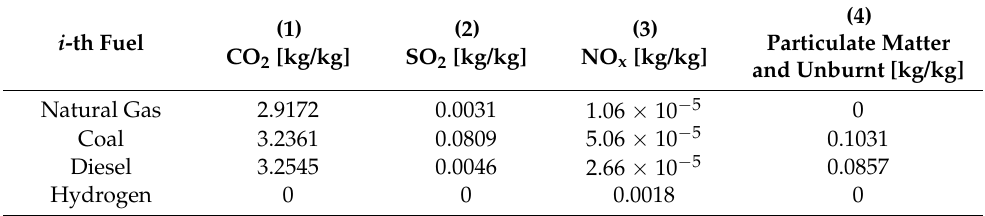
Table 3. Mass fraction of the main pollutants produced by combustion with air in burned fuel.